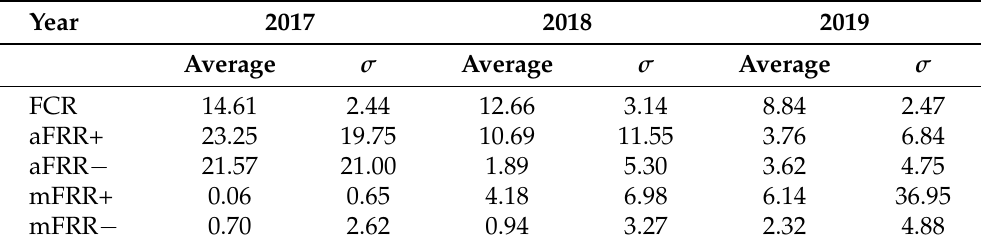
Table 3. Mean yearly price levels given in e /MWh on the balancing market including standard deviation σ , database